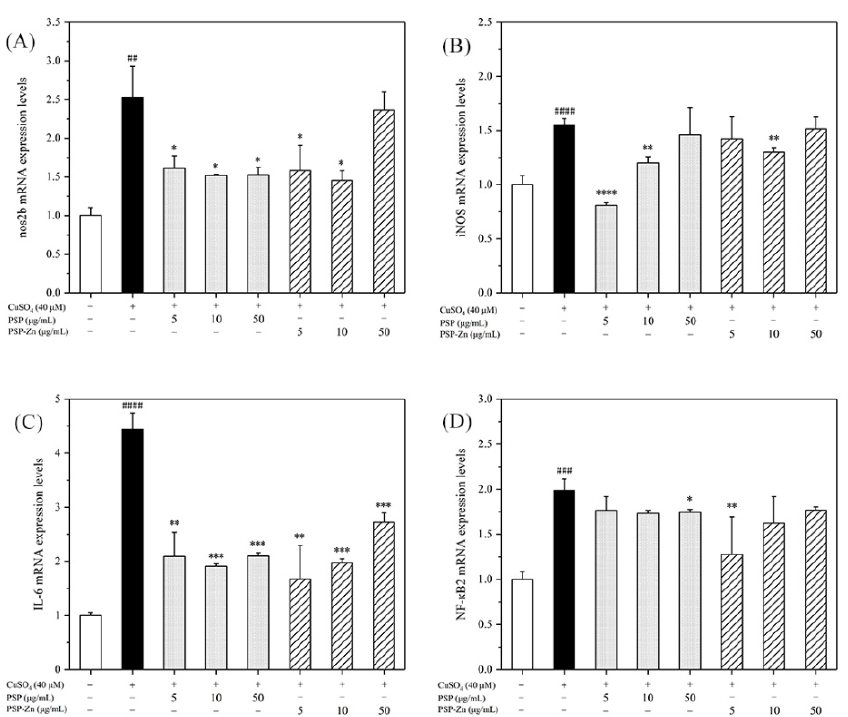
Figure 7. RT-PCR detects the expression of ( A ) nos2b, ( B ) iNOS, ( C ) IL-6, and ( D ) NF- κ B2. Data are shown as mean ± SD with n = 3. ## p < 0.01, ### p < 0.001, #### p < 0.0001 versus the control group; * p < 0.05, ** p <0.01, *** p < 0.001, and **** p < 0.0001 versus the model group.